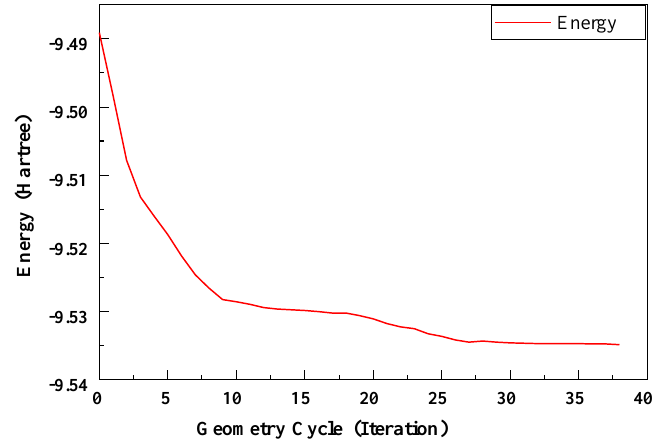
Figure 3. The energy minimization curve of cellobiose.